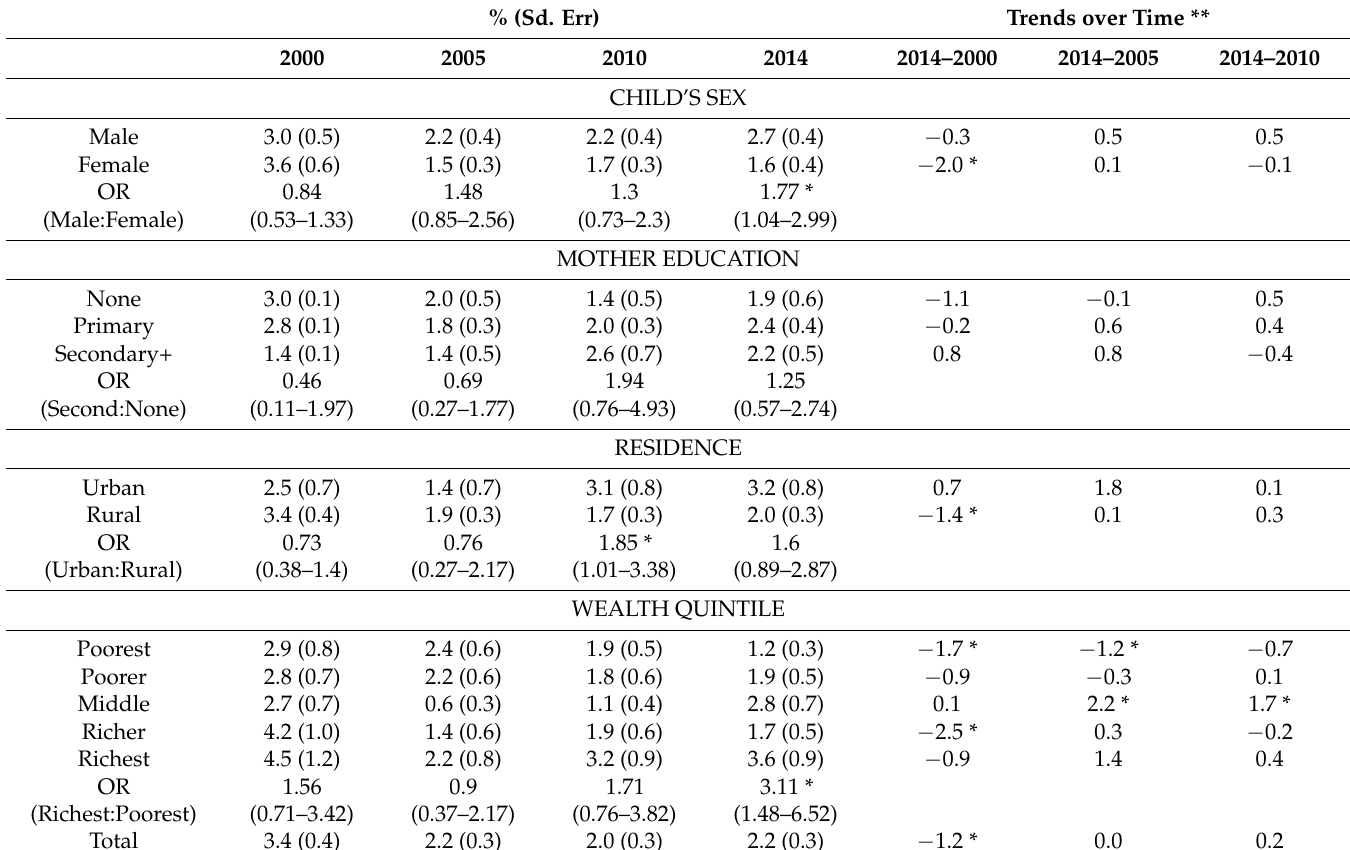
Table 5. Prevalence of overweight in children in the four surveys according to their social characteristics. % (Sd. Err) Trends over Time